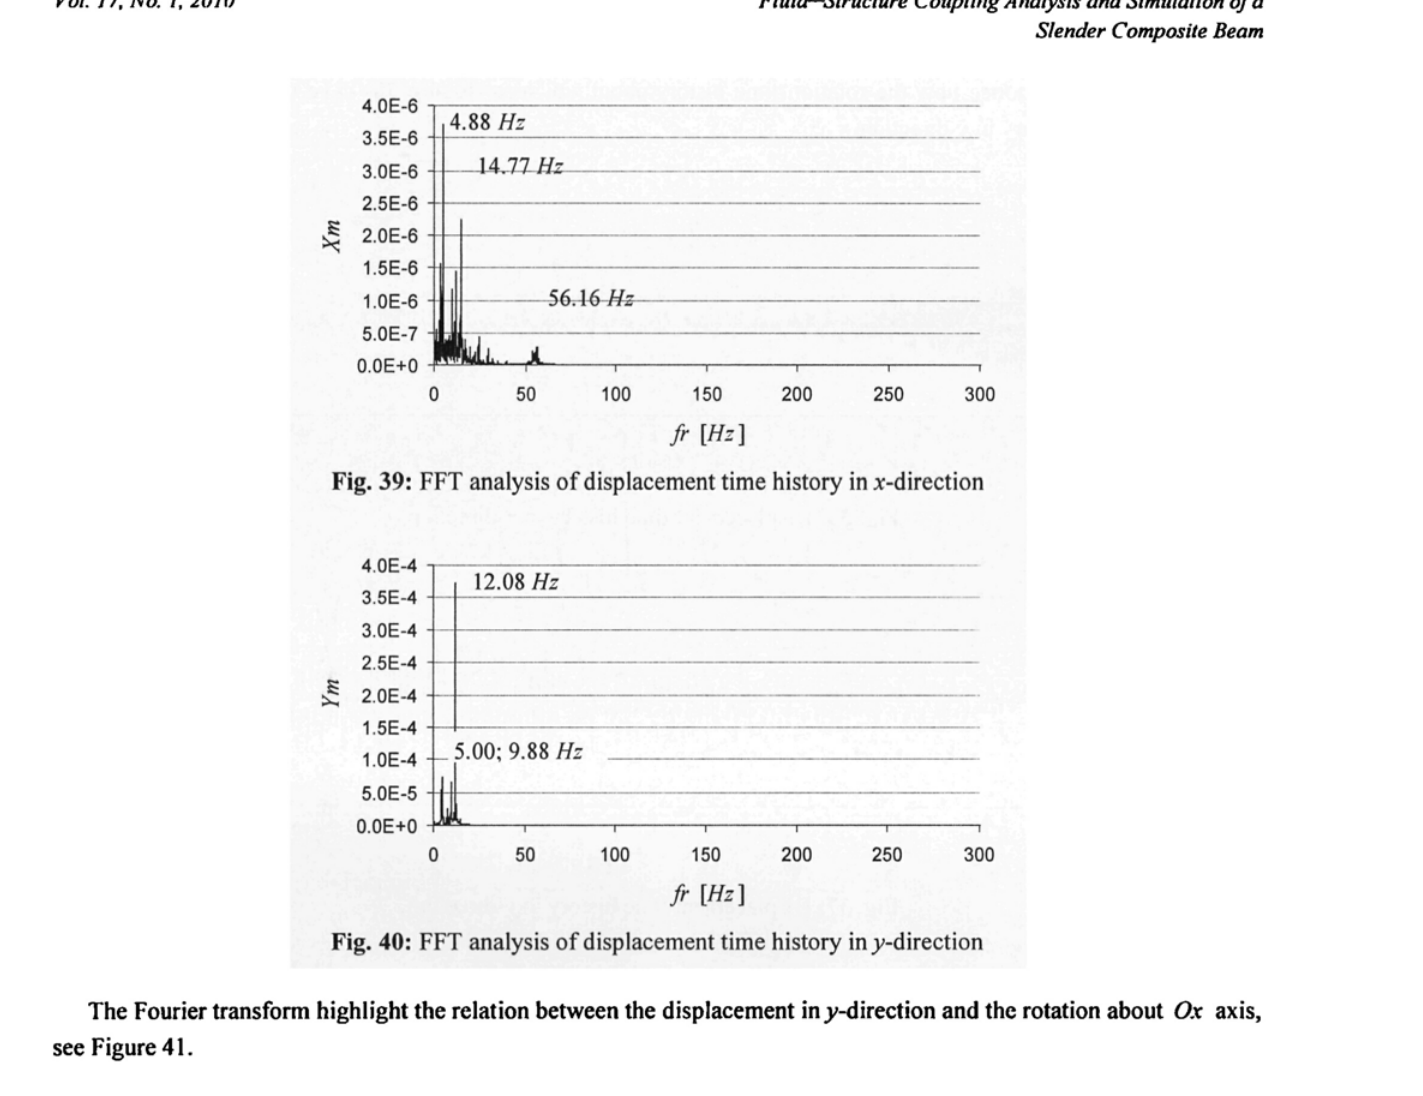
Fig. 41: FFT analysis of rotation time history about Ox